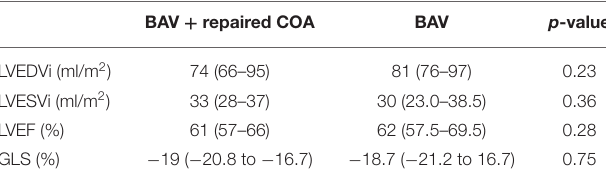
TABLE 2 | Results from CMR